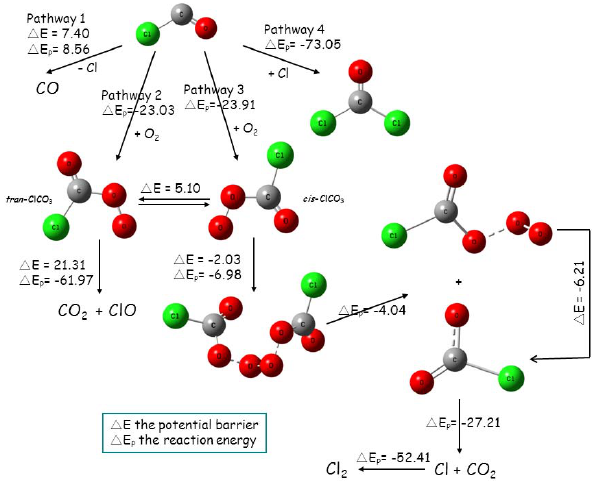
Fig. 3. Possible atmospheric degradation pathways of ClCO radical at the QCISD(T)/6–311+G(2df,2p)//PMP2/6–311+G(d,p) level (in kcal/mol).